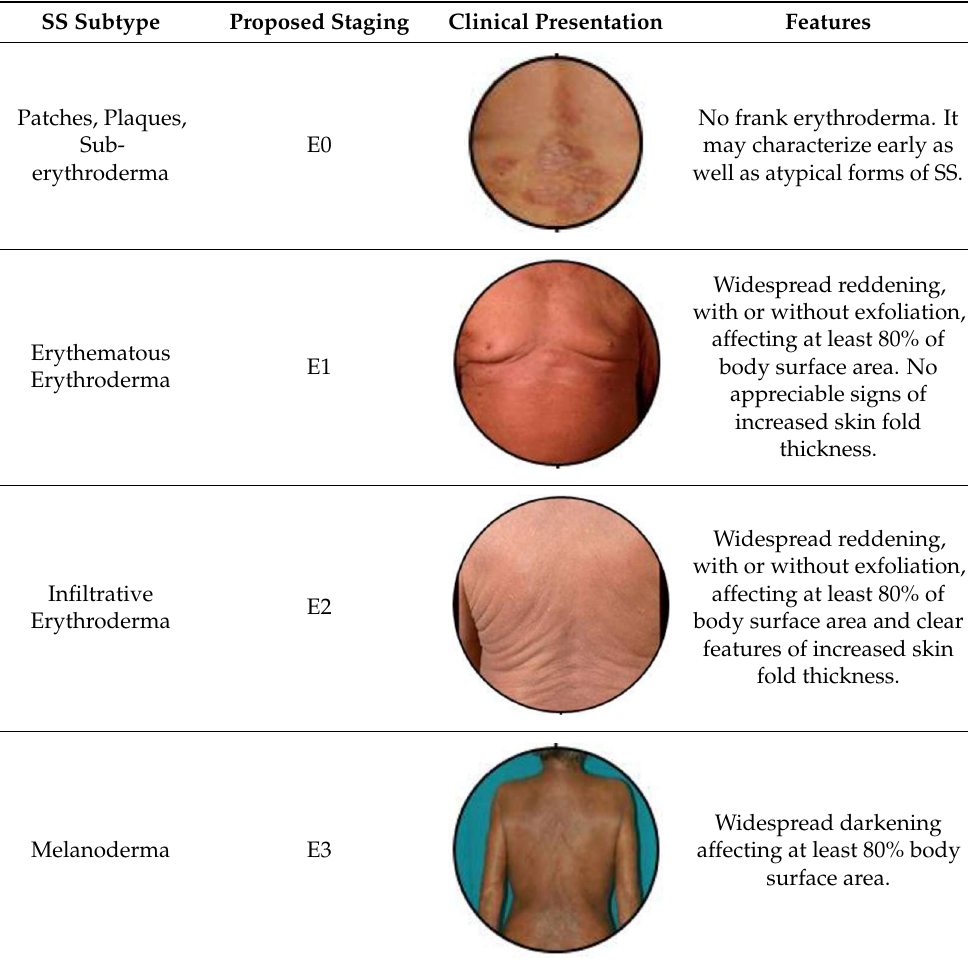
Table 2. New staging proposal according to SS features.